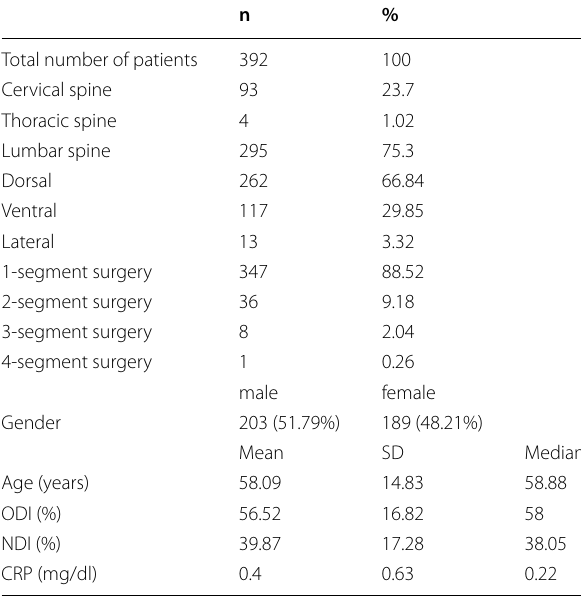
Mean, standard deviation and median for metric variables, and absolute and relative frequencies for nominal and ordinal variables for the total study